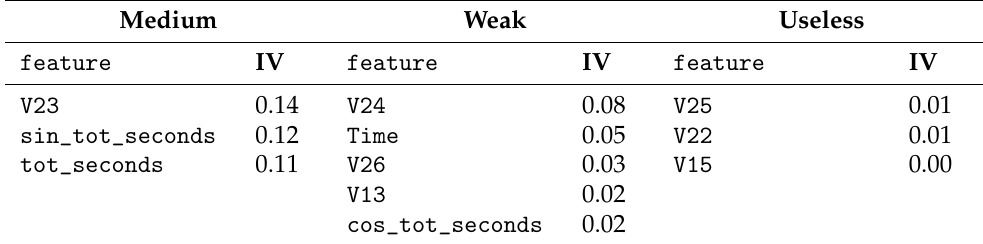
Table 9. Extended CreditCard dataset information value—Part